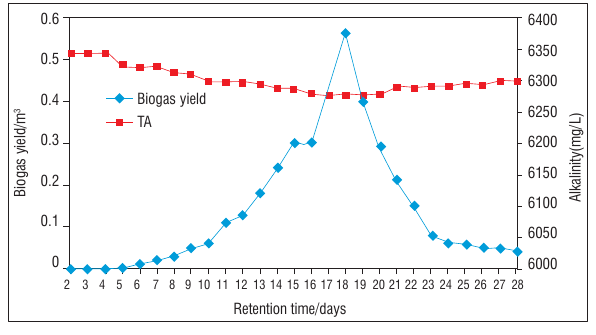
Figure 6: Relationship between biogas yield and total alkalinity for donkey dung The relationship between biogas yield and NH -N for donkey dung is 4 shown in Figure 7. The NH -N concentrations for donkey dung ranged 4 from 920 mg/L to 1223 mg/L. Therefore, donkey dung had appropriate NH -N levels to maintain stable anaerobic digestion performance. The 4 higher NH -N final values corresponded with lower biogas production. 4 The lowest NH -N concentration was 920 mg/L. We observed that 4 the lowest NH -N concentrations corresponded to the highest biogas 4 yield, and no inhibition occurred because the NH -N concentrations fell 4 within the desired optimum range (below 1500 mg/L) for better biogas production by the methanogens. Previous studies have reported that inhibiting concentrations of NH -N are higher than 1500 mg/L. 12-14 4